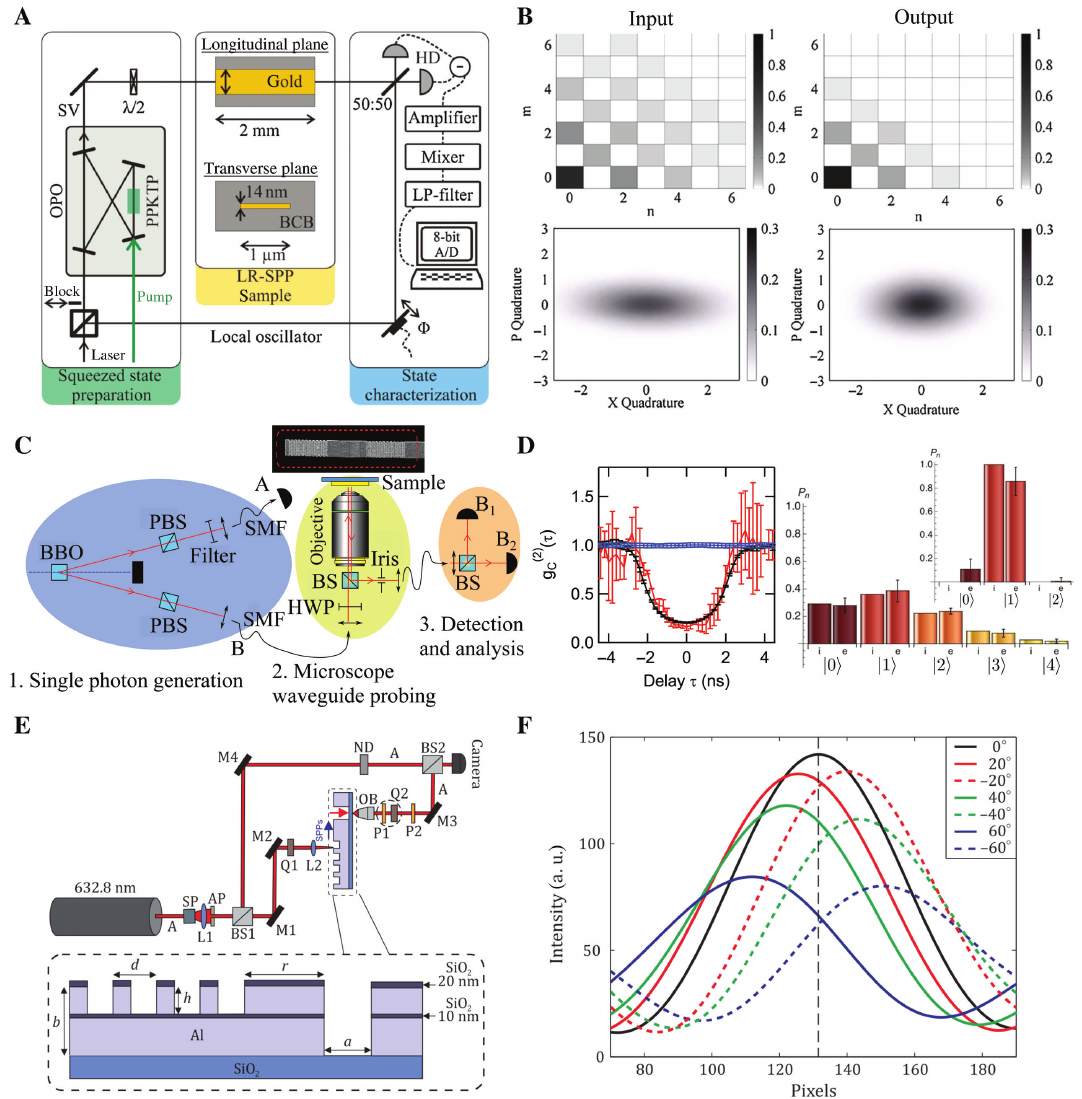
Figure 7: Experiments that demonstrate the preservation of quantum statistics in hybrid photonic-plasmonic systems. (A) Schematic of the experimental setup used for demonstration of quadrature squeezing preservation. OPO, optical parametric oscillator; PPKTP, periodically poled potassium titanyl phosphate crystal; SV, squeezed vacuum. (v) Experimentally generated and transmitted squeezed vacuum states after a photon-plasmon-photon process. The quadrature of the electric field, absolute values of the reconstructed density matrices, Wigner functions, and noise power relative to the shot noise level of input and output are also presented. (A and B) Reproduced from Ref. [137]. (C) Schematic of the setup used for the experimental demonstration of the preservation of quantum statistics in plasmonic waveguides. (D) Conditional second-order quantum coherence functions g (2) ( τ ) for light with nonclassical and classical statistical properties. The dotted blue line illustrates the classical limit. Right, corresponding two-photon number distributions. (c and d) Reproduced from Ref. [138]. (E) Schematic of the experimental setup for plasmonic control of the Pancharatnam-Berry geometric phase. This is demonstrated through the interference patterns in (F). The shift of interference fringes unveils the possibility of preserving geometric phases in plasmonic systems. AP, aperture; BS, 50/50 beam splitter; L, lens; M, mirror; ND, neutral density filter; OB, microscope objective; P, linear polarizer; SP, spatial filter; Q, quarter-wave plate. (e and f) Reproduced from Ref.